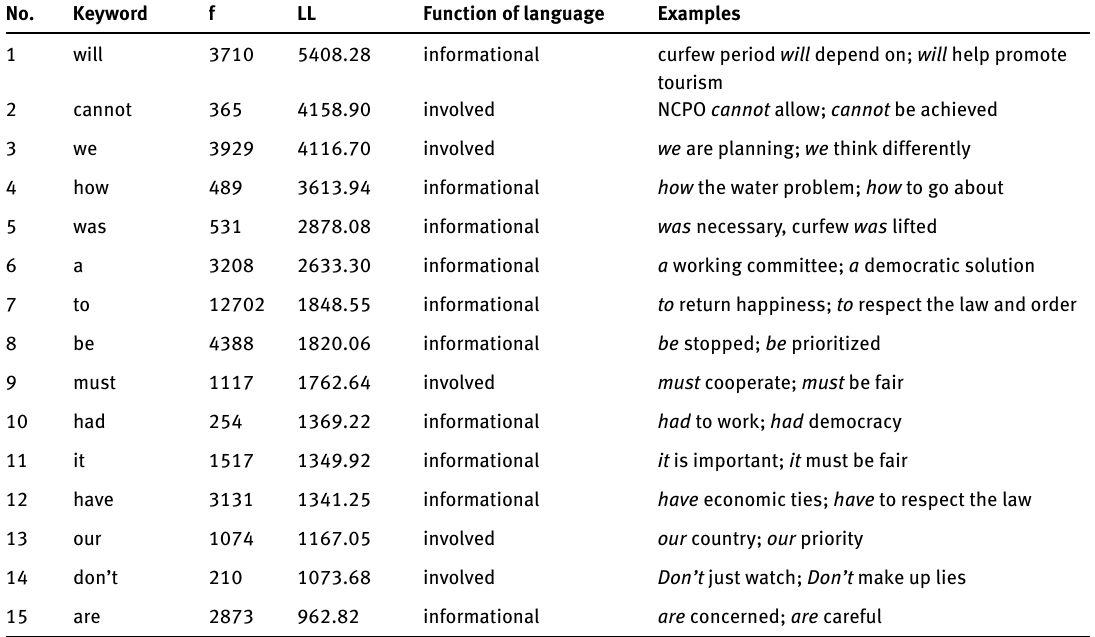
Table 4. Involved versus Informational production of language